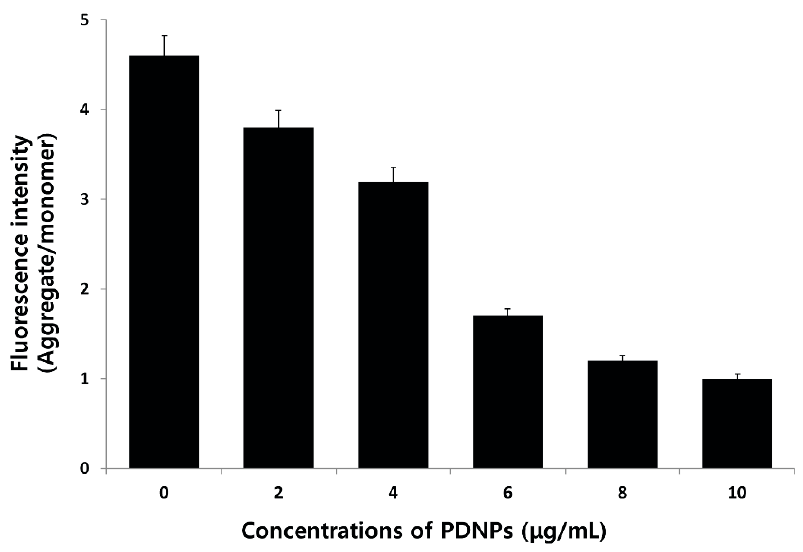
Figure 11. Effect of palladium nanoparticles (PdNPs) on mitochondrial membrane potential (MMP). MMP (ratio of JC1 aggregate to monomer) in ovarian cancer cells determined after treatment with different concentrations of PdNPs for 24 h.